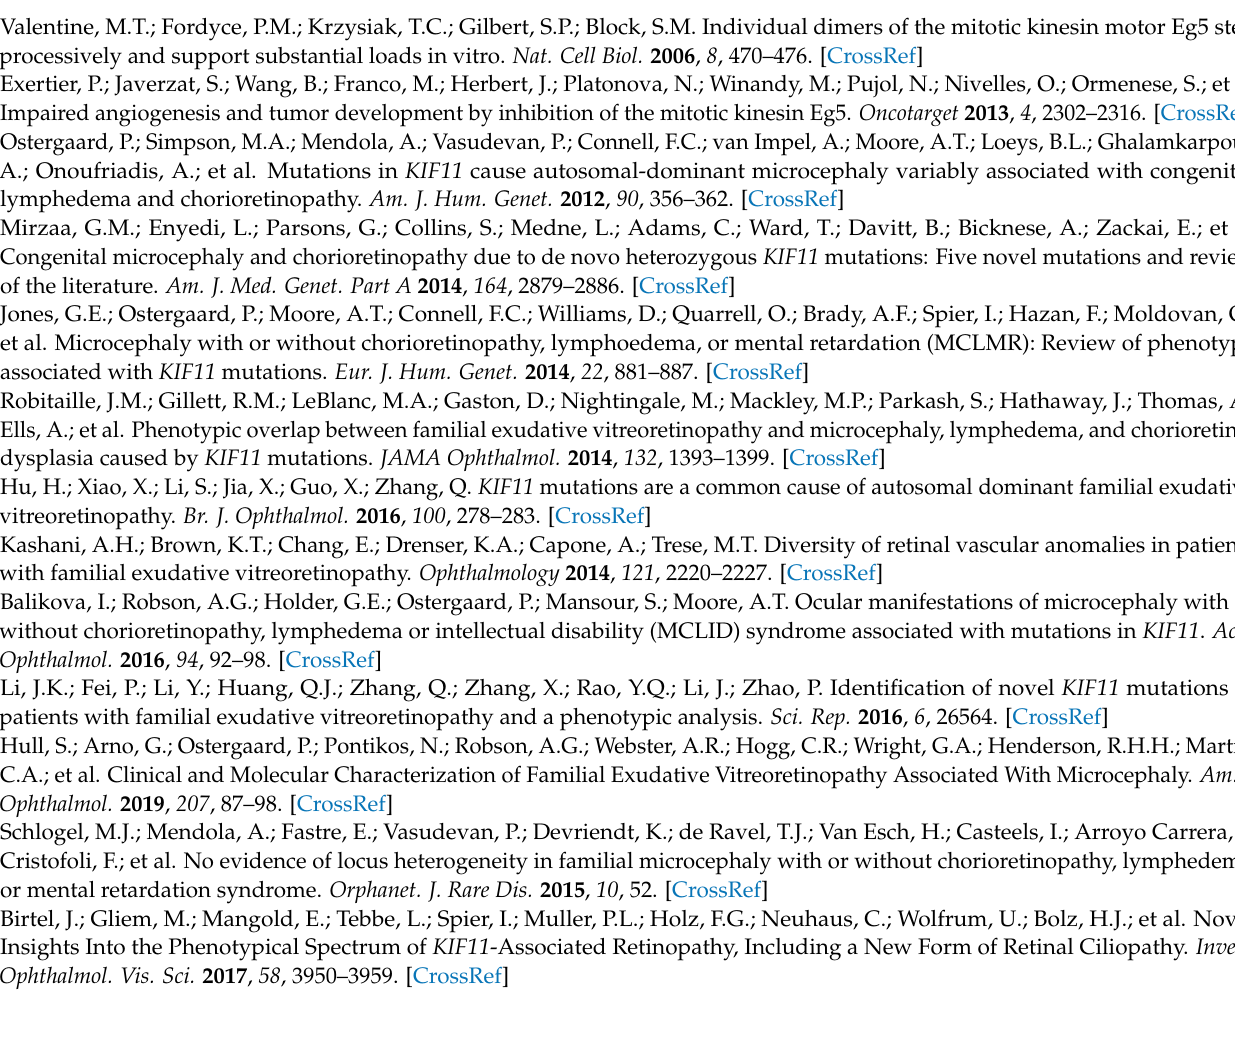
Table S3: The results of STR analysis for HEK-293 cell line authentication; Table S4: In silico analysis of the identified splice-altering variants in